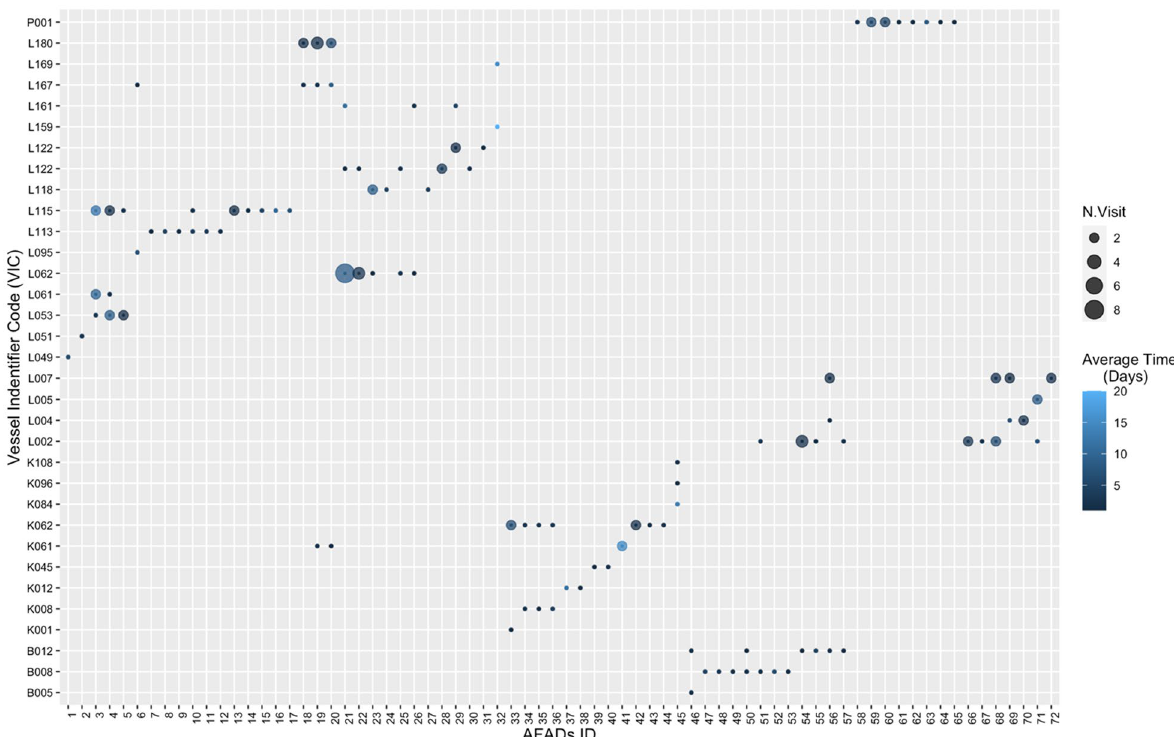
Figure 3. Number of AFADs used by each vessel (shown on the x axis) and the average time each vessel spent fishing on confirmed AFADs during the study period (Days). The number of visits is depicted by the size of the circles, as per figure